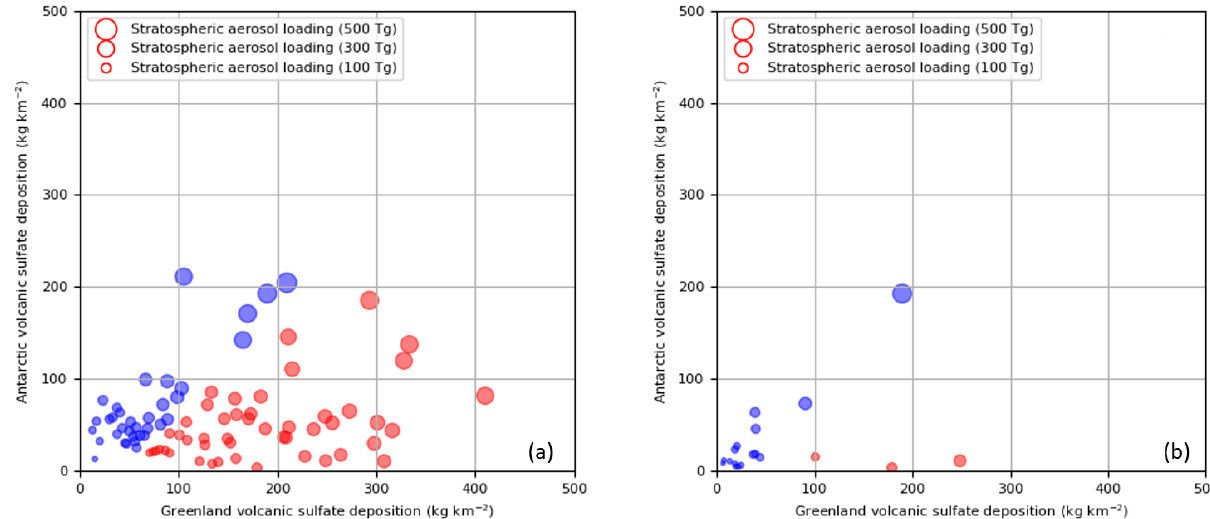
Figure 1. Relationship between Greenland and Antarctic volcanic sulfate deposition for the large bipolar volcanic eruptions. The size of the circle relates to the stratospheric sulfate aerosol loading. (a) Volcanoes in the last glacial period are classified by a support vector machine (SVM) model with latitudinal bands: above 40 ◦ N in red circles, below 40 ◦ N in blue circles. (b) Volcanoes of the last 2500 years for which the eruption site is known (listed in Table S6) are classified with the latitudinal bands as for (a)